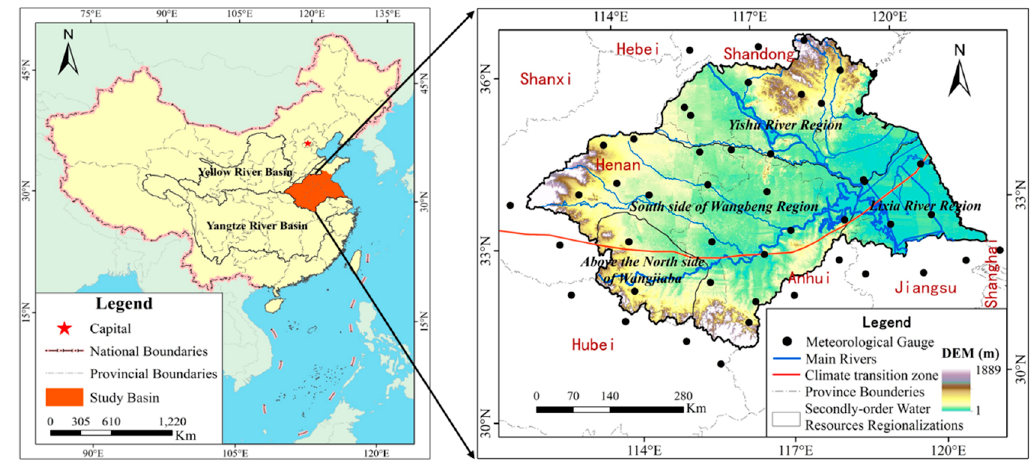
Figure 1. The inset map displays the location of the Huaihe River basin (red shading) in China. The main map shows the location of the Huaihe River basin where the bold black line reveals the boundary of the Huaihe River. The location of the meteorological stations showed by the black circle.